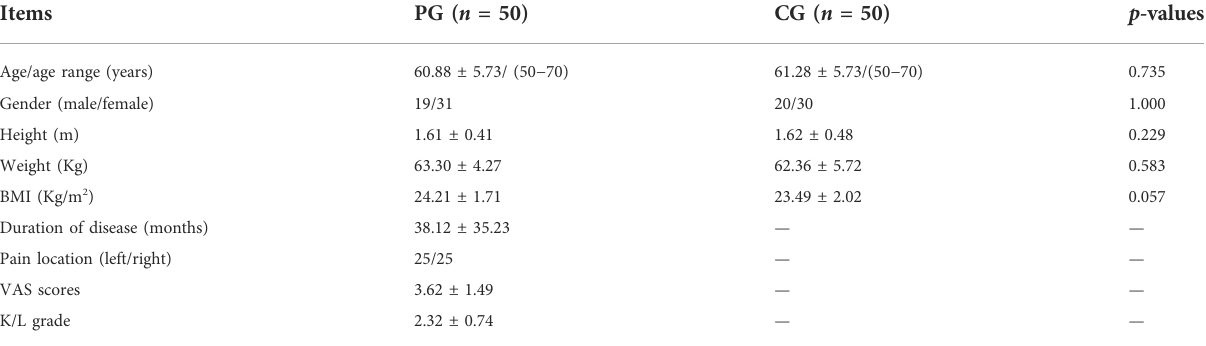
TABLE 1 Baseline condition of subjects ( n = 100).